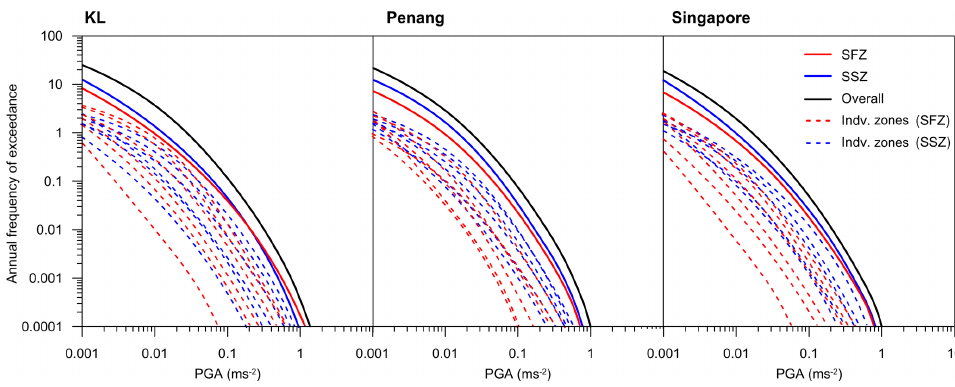
Figure 15. Source contribution hazard curve for KL, Penang and